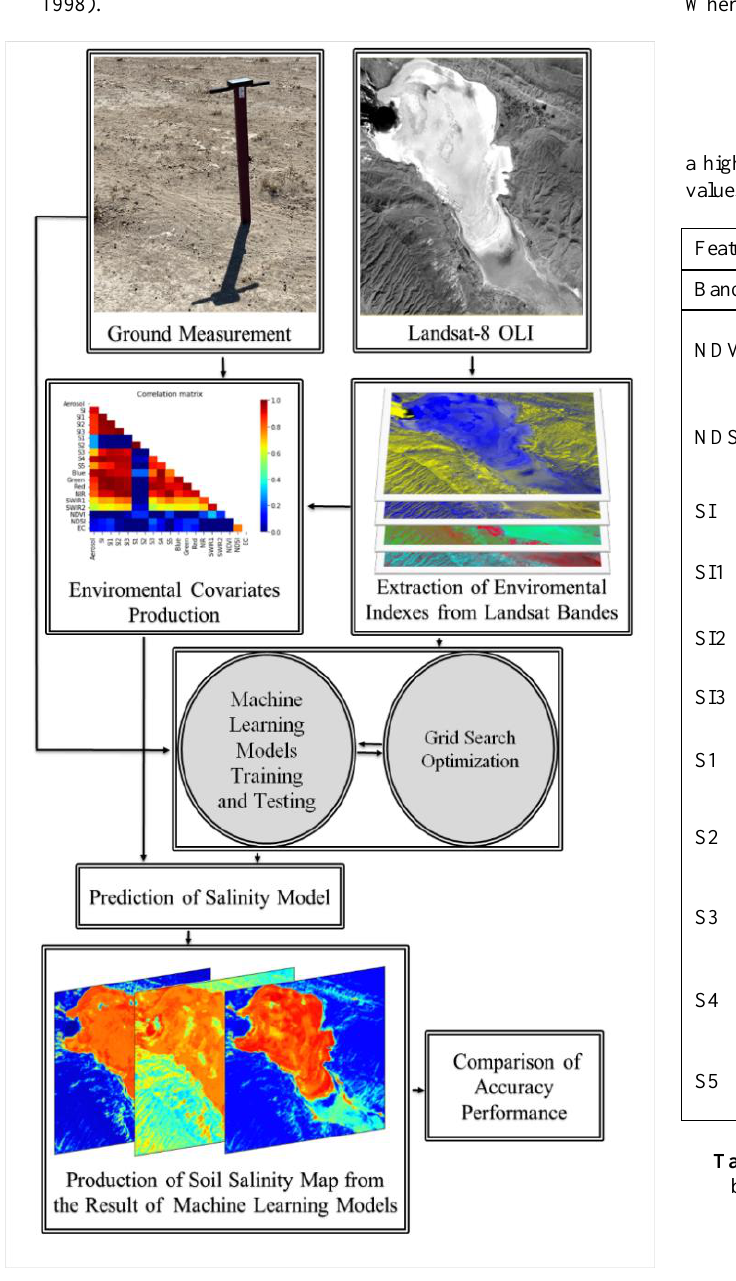
Figure 4 . Flowchart of the methodology used in Maharloo Salt Lake to estimate soil salinity.